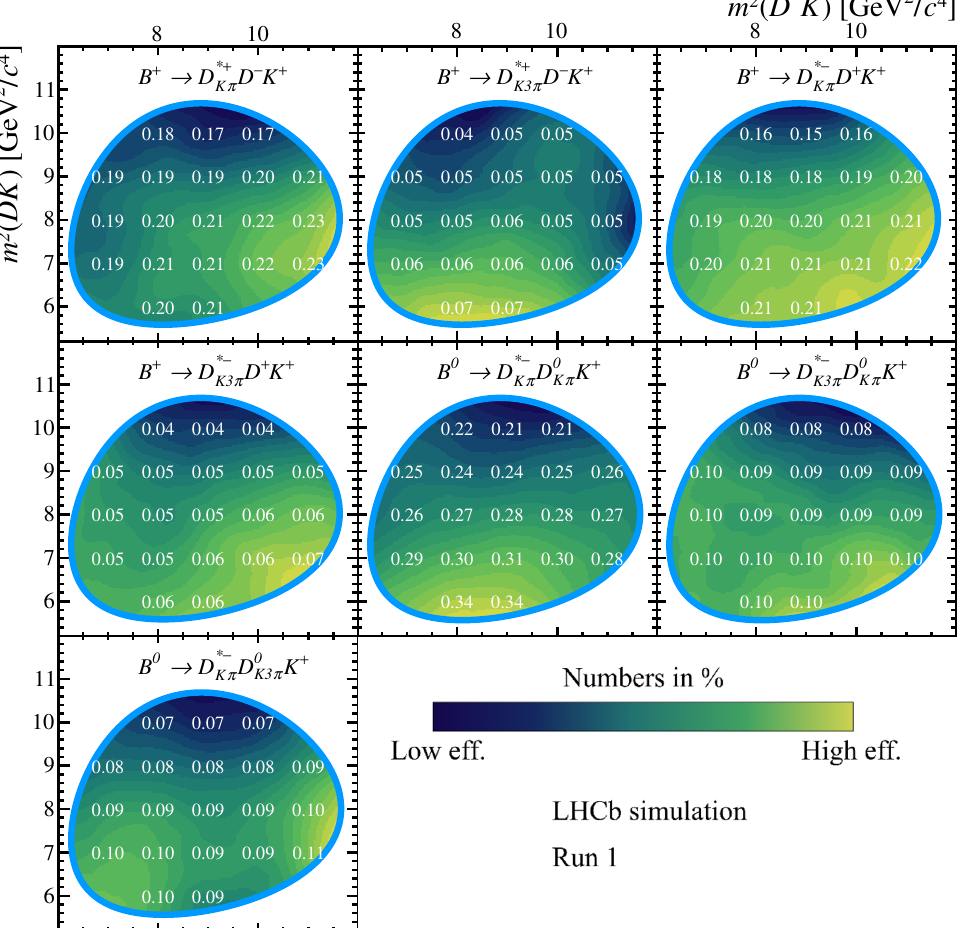
Figure 3 . Selection and reconstruction efficiency, ε sel , as a function of position in the two-body squared invariant-mass plane for the seven B → D ∗ DK modes, obtained using Run 1 simulated samples. A KDE smoothing has been applied. The blue lines indicate the kinematic boundaries and the numbers indicate the value of the efficiency at several points in the phase